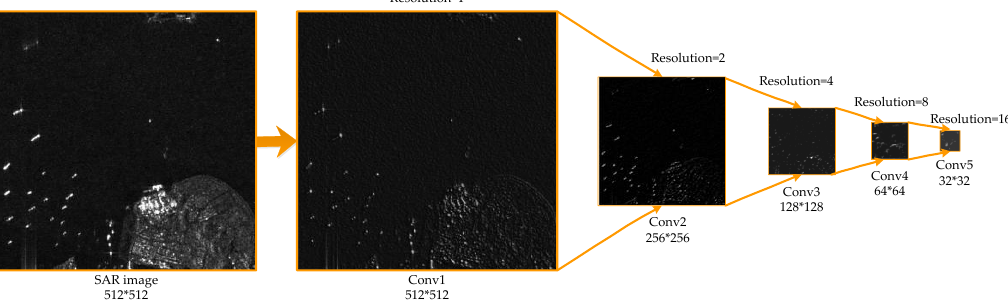
Figure 2. The feature maps of different layers in VGG16. With the increasing of resolution, the feature map becomes smaller and more semantic.